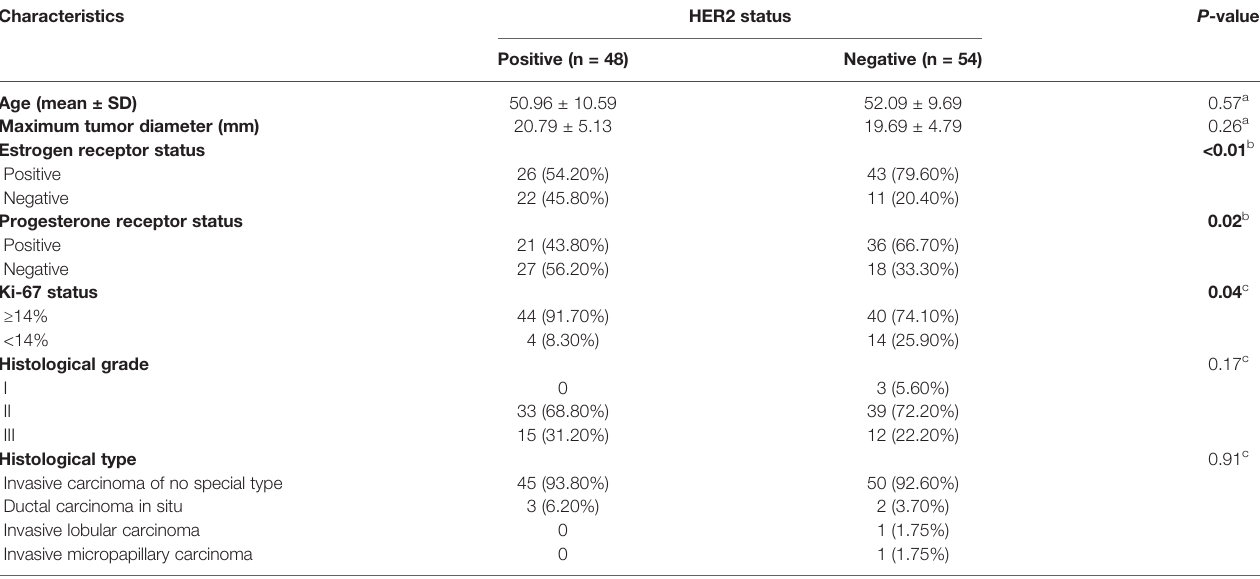
TABLE 2 | Clinical and histopathological characteristics of all patients.